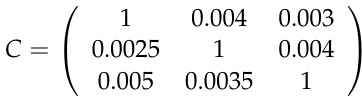
Figure 7. Evolution of x 1 ( k ), x 2 ( k ) and x 3 ( k ) for constant parameters in Example 4. Species 1 domi- nates the other two and harvesting quota and consumption are included.